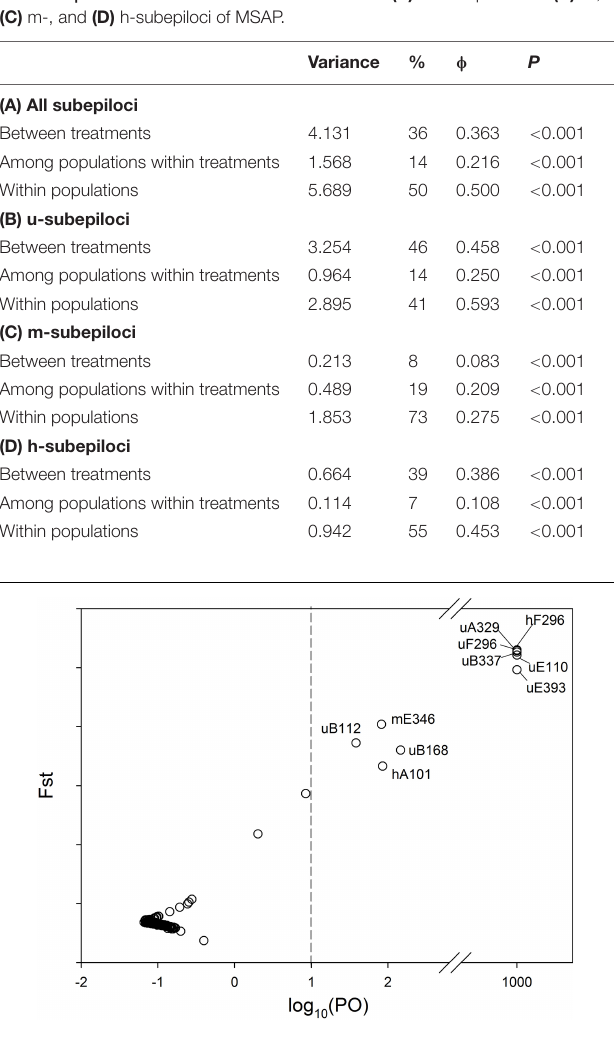
u-subepiloci, 46 and 41%, respectively; for h-subepiloci, 39 and 55%, respectively). However, for m-subepiloci, variation mainly existed within experimental populations